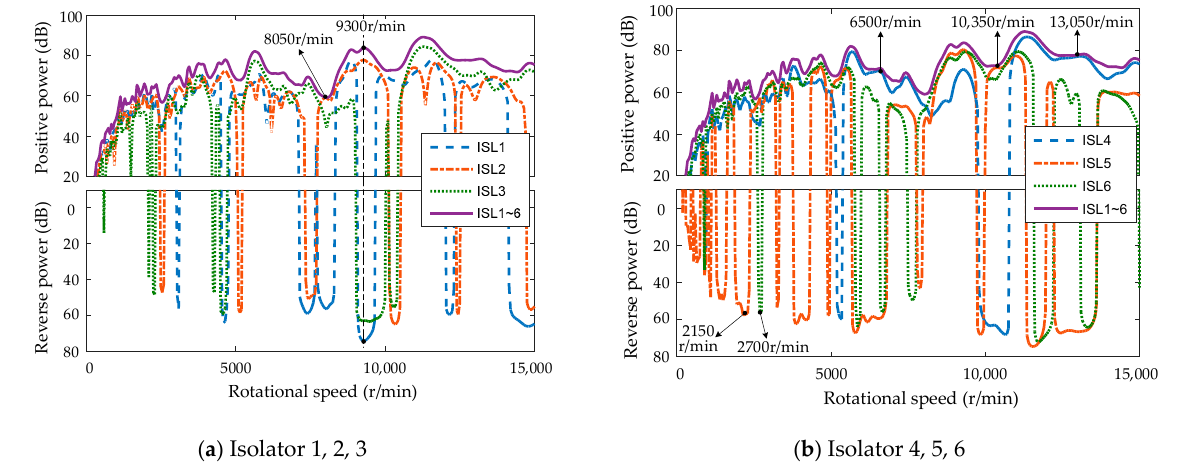
Figure 17. Isolator foundation transmitted power—location path. Reverse power flow may exist at each isolator connection. For example, the total vibration power near 2150 r/min is 61.1 dB, and the reverse power at isolator 5 is 57.5 dB. The total vibration is 60.3 dB near 2700 r/min, and the reverse power of isolator 6 is as high as 56.4 dB. The total vibration near 8050 r/min is 59.0 dB. At this time, the reverse power of isolator 1 is as high as 56.4 dB, which can compress the vibration greatly. The transmission power corresponding to the direction path is shown in Figure 18. Generally speaking, the vertical direction uy domains the vibration of the foundation, but other DOF also contributes to a certain degree below 3800 r/min. For example, the overall vibration is 64.6 dB near 2200 r/min, the ux direction vibration is 63.4 dB, and the uy direction vibration is only 51.4 dB. The total vibration is 74.5 dB near 3450 r/min and 74.2 dB in the uz direction, while the vibration in the uy direction is only 54.1 dB at this time. At some rotational speed, such as 1100 r/min and 1700 r/min, there are even reverse power flows in the uy direction, with the amplitudes of 51.9 dB and 44.3 dB, respectively. At this time, the total vibration power is 55.3 dB and 65.3 dB, respectively. It shows that the uy direction has an obvious vibration suppression effect at 1100 r/min, but has little influence near 1700 r/min.